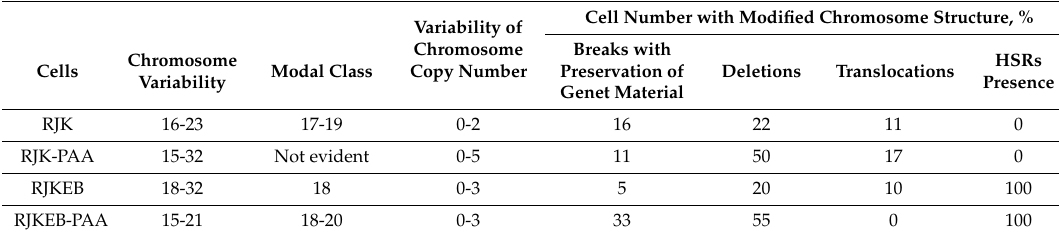
Table 2. Karyotype characterization of RJK, RJKEB, RJK-PAA, RJKEB-PAA cells. Cell Number with Modified Chromosome Structure, Variability of Chromosome Copy Number